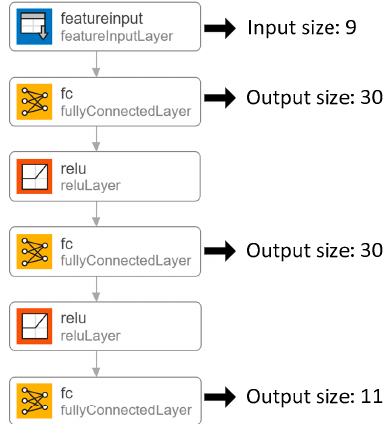
Figure 9. Network configuration of DQN agent.